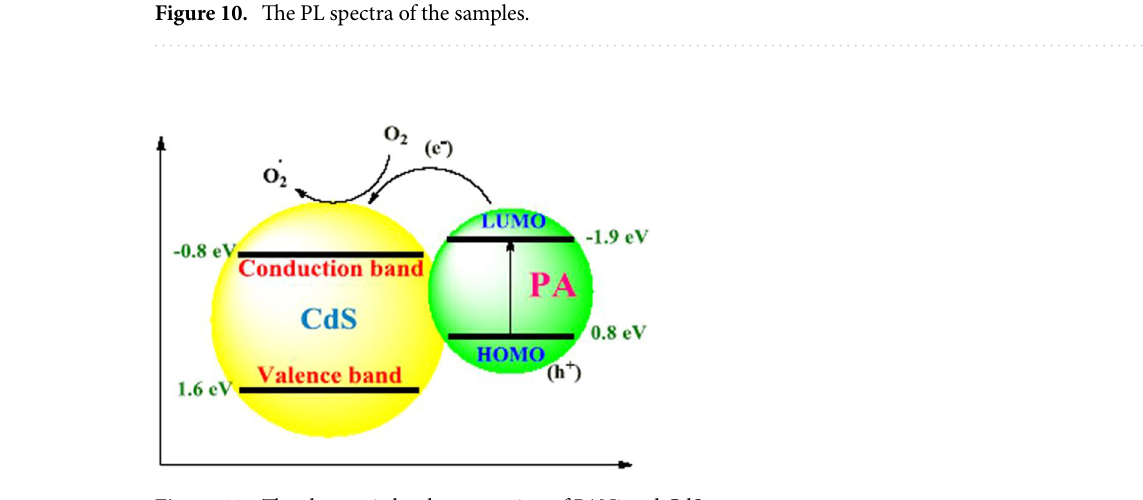
Figure 11. The electronic levels connection of PANi and